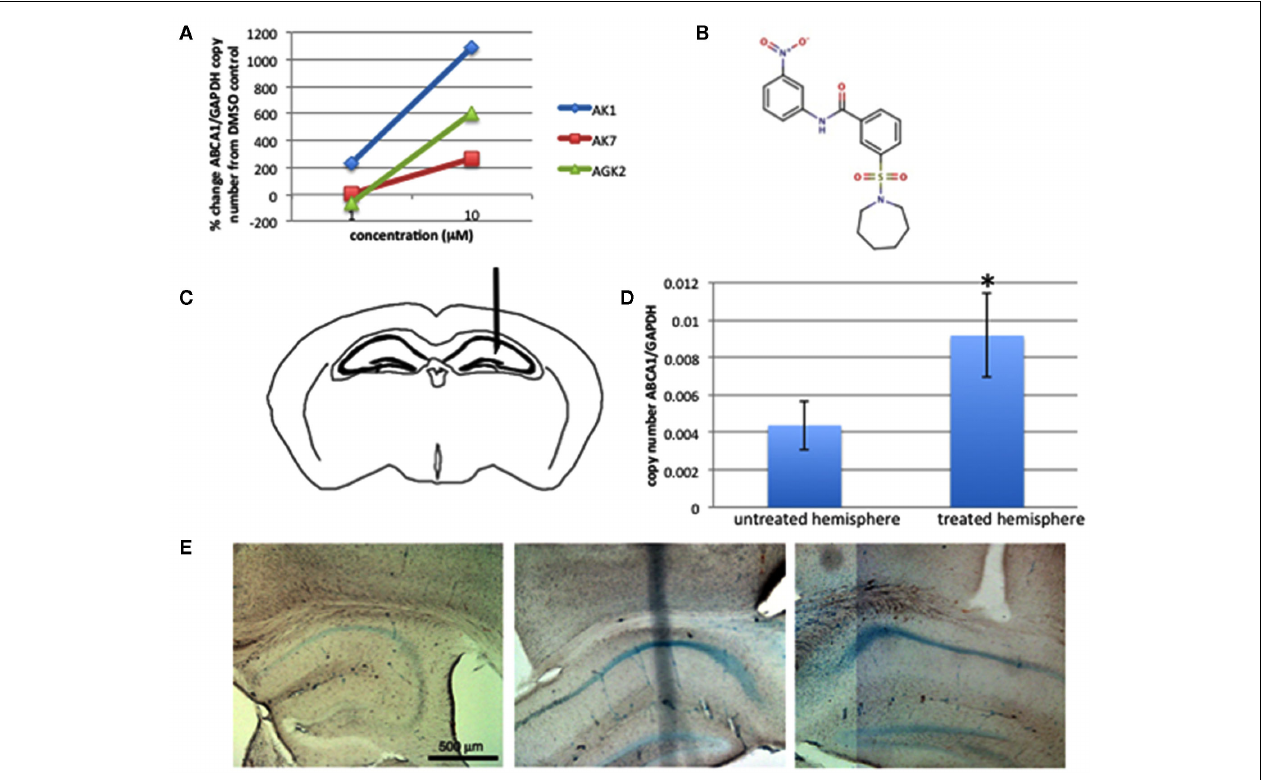
wild-type mice increases ABCA1 expression in the treated hemisphere compared to the untreated hemisphere [ (D) , p < 0.05], indicating the drug reached the brain.Trypan blue pumped for 7days further confirms the cannula placement in the hippocampus and shows spread of pumped material through the entire hippocampal formation (E)